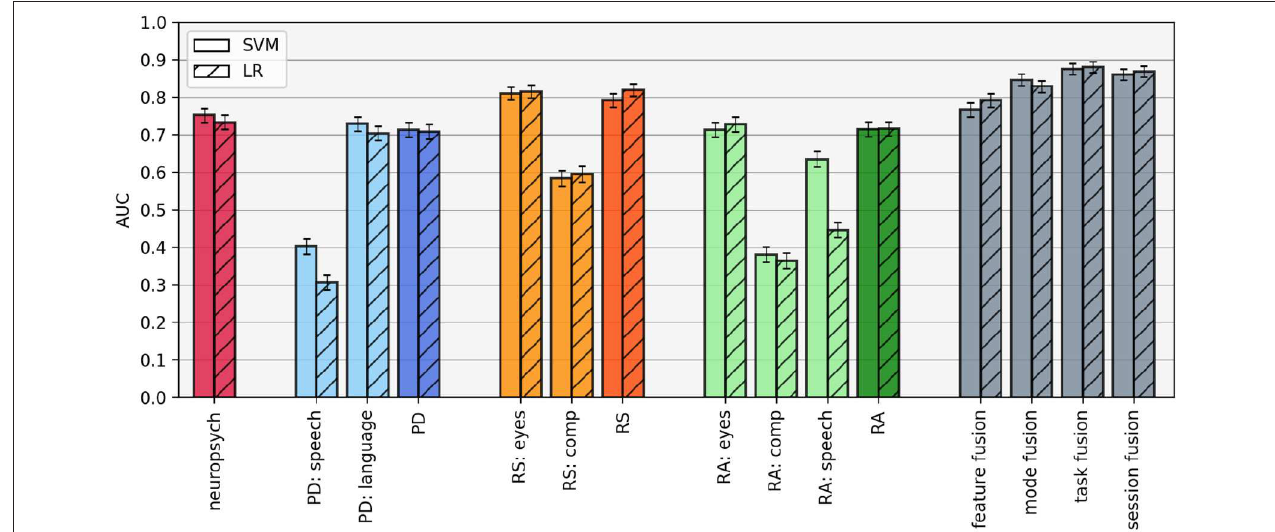
FIGURE 4 | Area under the ROC curve (AUC) for each classification configuration, estimated using leave-pair-out cross-validation. Error bars represent standard deviation over each fold in the cross-validation. PD, picture description; RS, reading silently; RA, reading